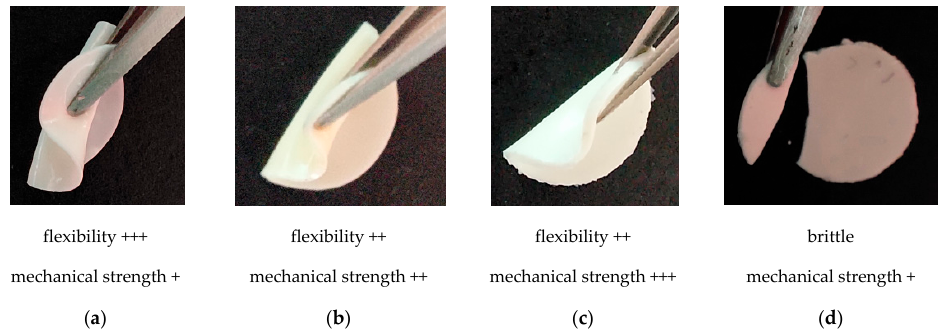
Figure 2. Thiol–ene ionogels obtained by polymerization of the system: ( a ) DAP + PETMB, ( b ) GBDA + PETMB, ( c ) TAT + PETMB, ( d ) TATT + PETMB. The puncture-resistance tests results (mechanical strength) are presented in Figure 7.